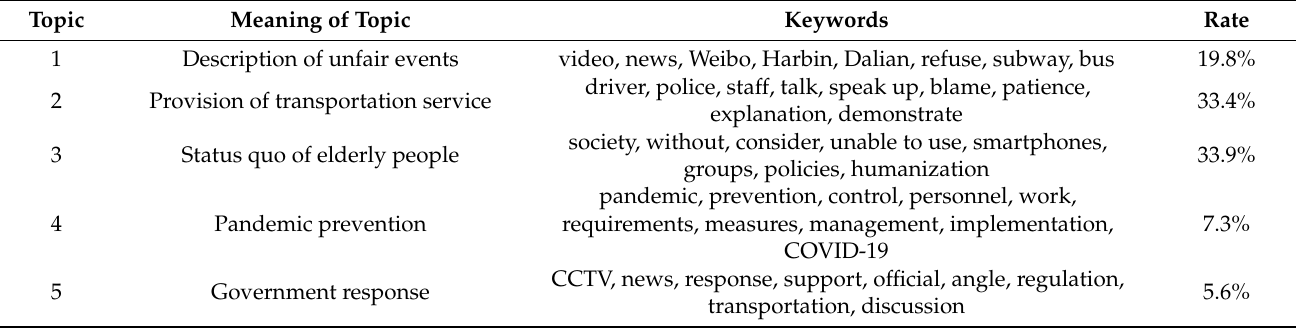
Table 1. Recognition results of the latent Dirichlet allocation (LDA) model.